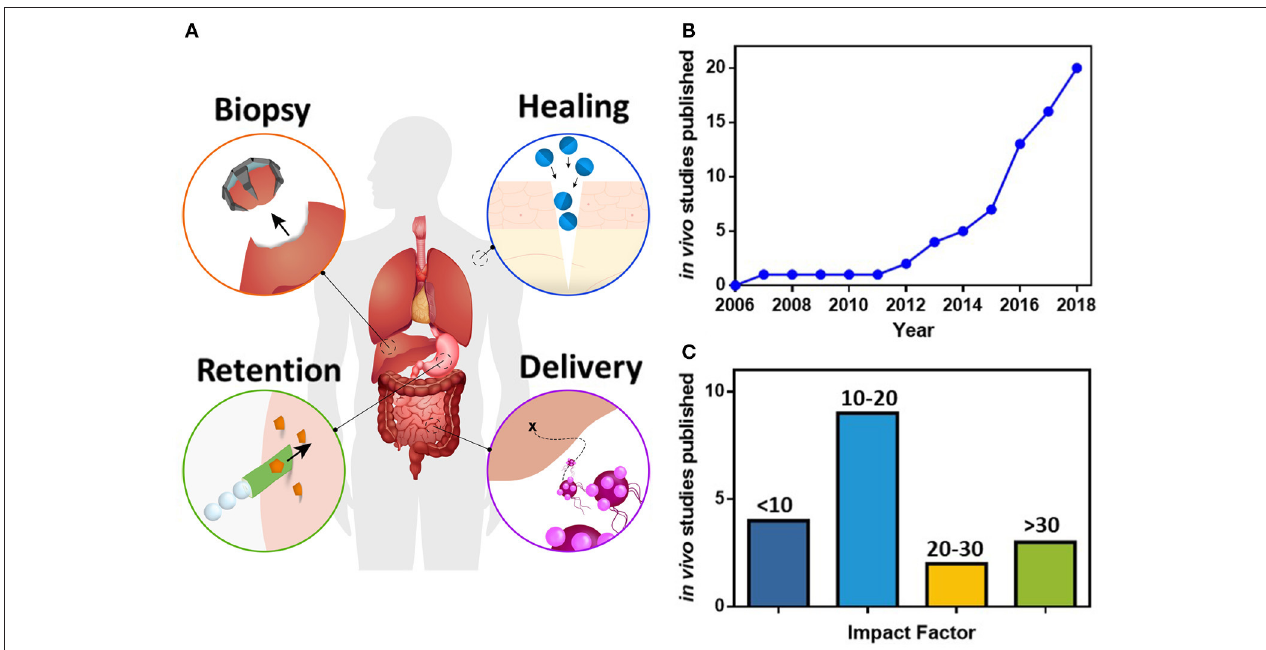
FIGURE 1 | (A) Scheme of medical perspectives in micro/nanorobotics for in vivo human applications, including machines capable of performing biopsy (Gultepe et al., 2012), healing wounds (He et al., 2016), enhanced retention in tissues (Gao et al., 2015), and deliver their cargoes to specific destinations (Felfoul et al., 2016). Analysis of the published articles (see Table 1 ), including micro/nanorobots for in vivo applications, showing (B) the cumulative number of published articles, and (C) the impact factor of those